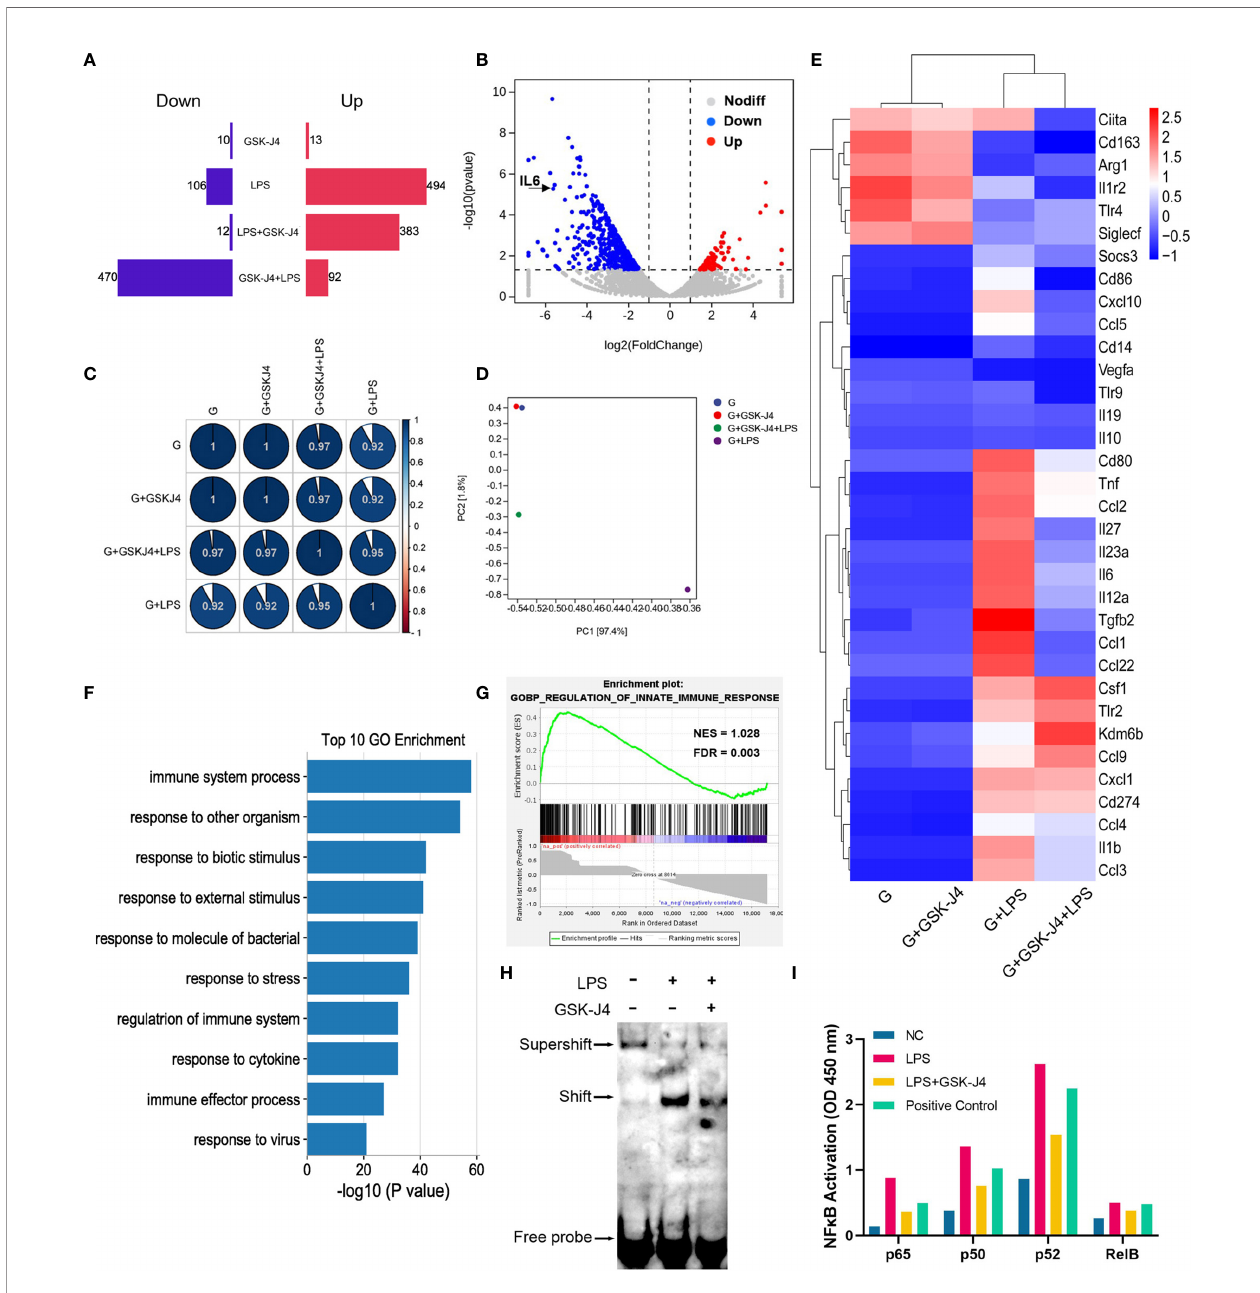
FIGURE 5 | H3K27me3 in fl uences gene transcription via reducing NF k B binding activity. (A – G) GM-BMDMs were treated with GSK-J4 for 48 hours (GSK- J4), or LPS for 1 hours (LPS), or pretreat with GSK-J4 for 48 hours then LPS for 1 hour (GSK-J4+LPS), or GSK-J4 and LPS co-stimulation for 1 hour (LPS +GSK-J4). After treatments, the cells were harvested, and the RNA were used for RNA-seq. (A) Amount of up (red) and down (blue) regulated genes, GSK- J4 stimulated for 48 hours or co-stimulated with LPS for 1 hour. (B) Volcano diagrams represent the distribution of DEGs in LPS vs. GSK-J4+LPS groups in GM-BMDMs. (C) Gene expression correlation index after normalization. (D) PCA analyses of indicated treatment groups in GM-BMDMs. (E) Heatmap of portion of immune related genes in the indicated treatment groups in GM-BMDMs. (F) Top 10 biology processes of GO terms with DEGs of LPS vs. GSK-J4 +LPS groups. (G) GSEA analyzed Top one GSEA plot of LPS vs. GSK-J4+LPS. (H) EMSA assay detected NF k B probe binds to nucleus samples of LPS stimulated GM-BMDM with or without GSK-J4 treatment. (I) GM-BMDMs were left untreated (NC), LPS treated for 1 hour, or LPS+GSK-J4 co-treated for 1 hour. The cells were harvested, and the nuclei were isolated. The nuclear lysis was then applied to the ELISA plate coated with the antibodies against different NF k B subunits. Binding activities of these samples on p65, p50, p52, Rel B subunits were then detected, Raji samples provided by kit worked as the positive